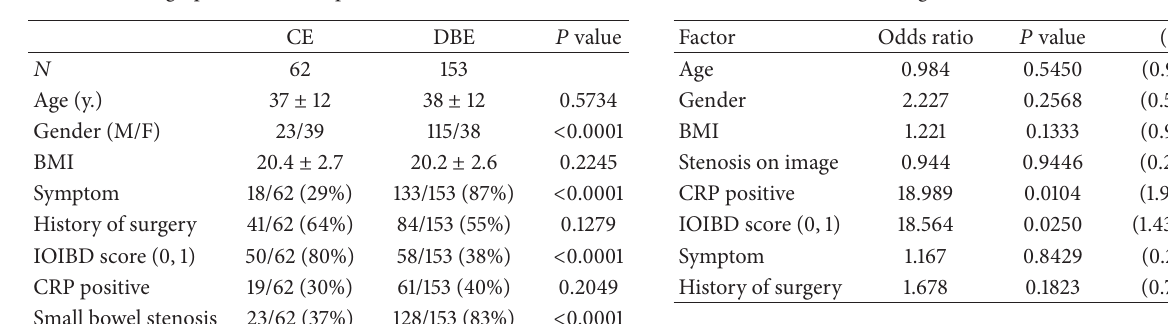
Table 2: Demographic data of the patients at the first examinations. Table 3: Factors affecting the role of CE—univariate analysis.